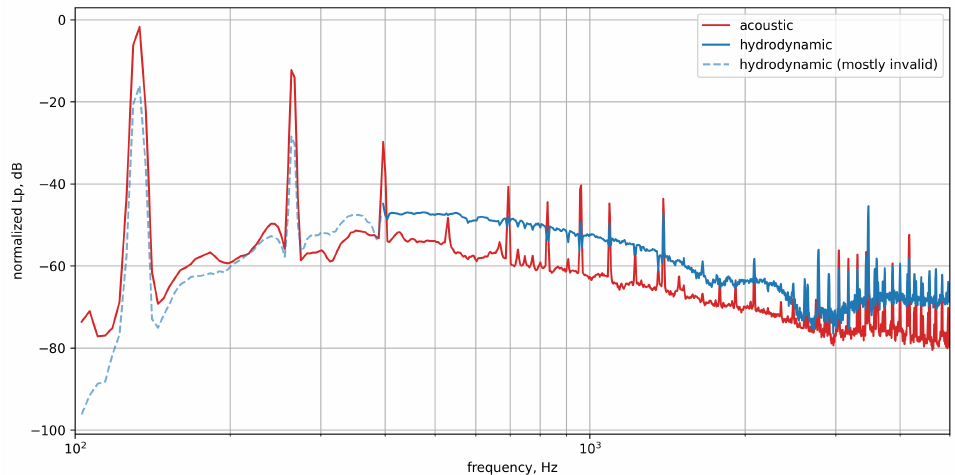
Figure 16. Separated spectra of acoustic pressure fluctuations and hydrodynamic pressure fluctua- tions. The performance of separation is best in the mid-frequency range as indicated by the solid line for the hydrodynamic pressure